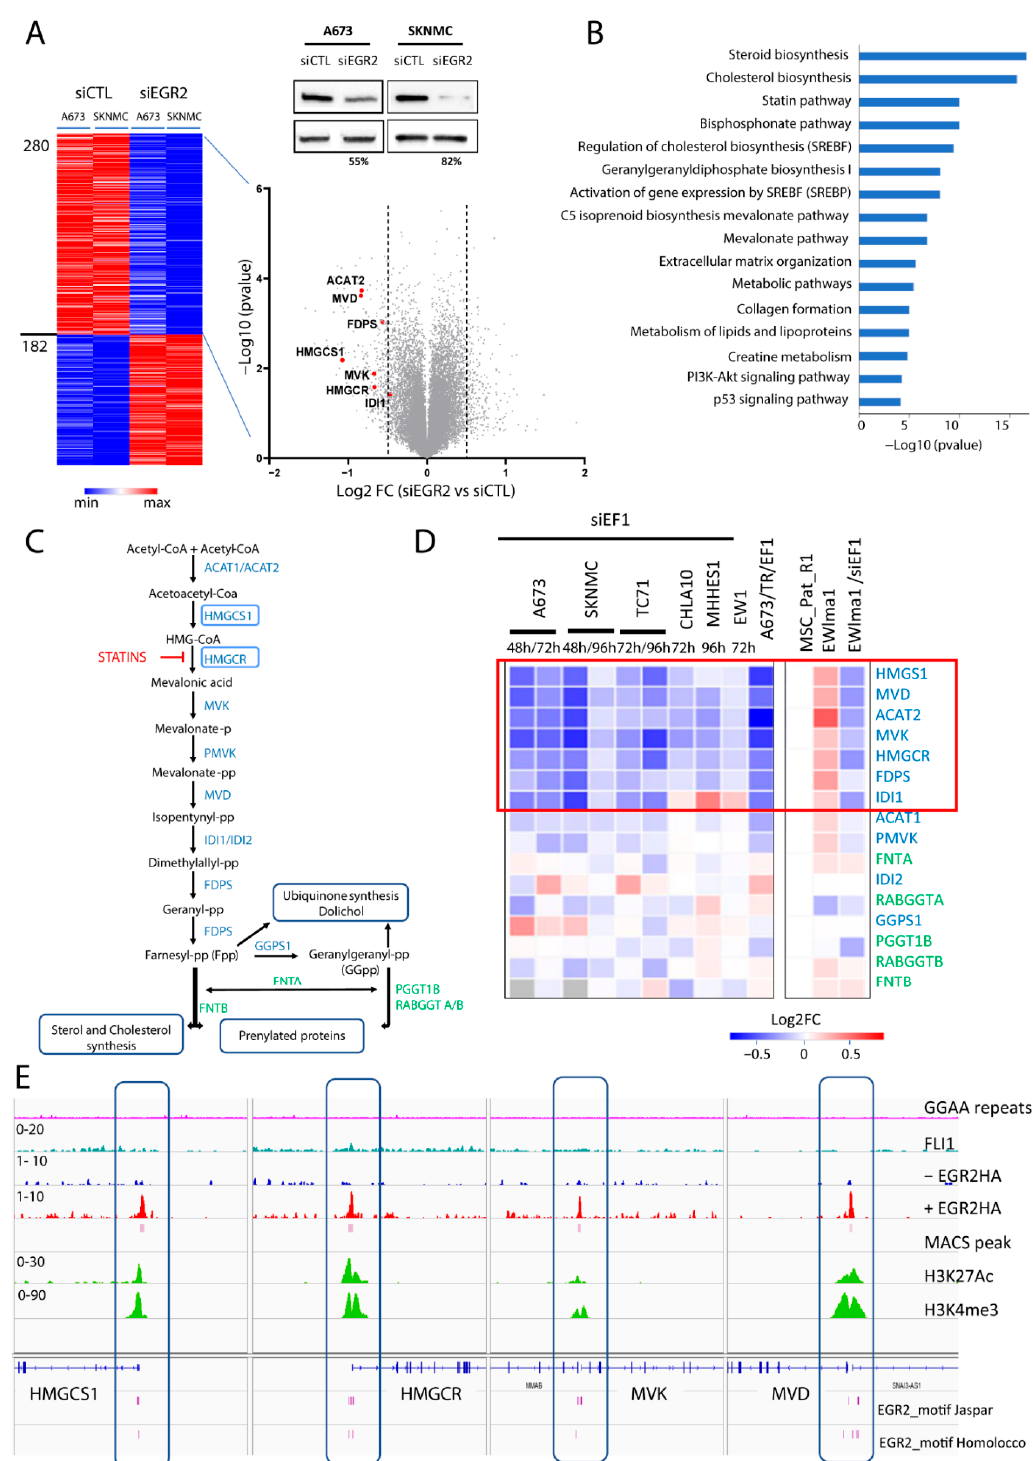
Figure 1. EGR2 regulates the expression of mevalonate pathway enzymes in Ewing cells. ( A ) Heat map of differentially expressed genes in the A673 and SKNMC Ewing cell lines obtained from the mean of two siEGR2 (#1 and #2) (absolute log2FC > 0.5) and Western blot analysis of EGR2 expression cells for 48 h after siEGR2 or siCTL transfection. The volcano plot shows the differentially expressed genes in A673 and SKNMC Ewing cells upon siEGR2 vs. siCTL transfection. The dotted line corresponds to the absolute value of log2FC = 0.5 and the red dots point out mevalonate pathway genes down-regulated by EGR2-KD. ( B ) Gene Ontology and pathway analysis using the